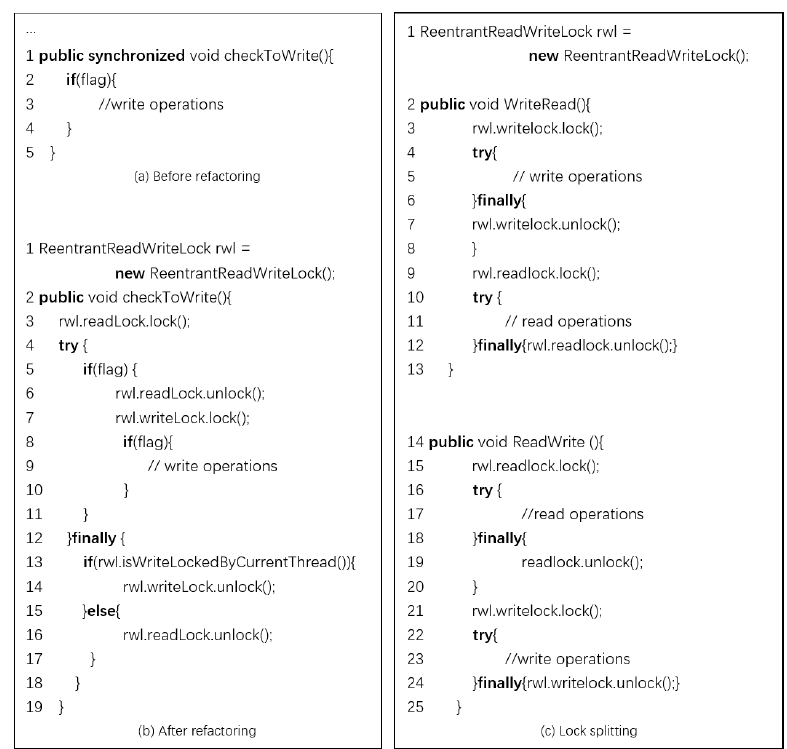
Figure 5. splitting of